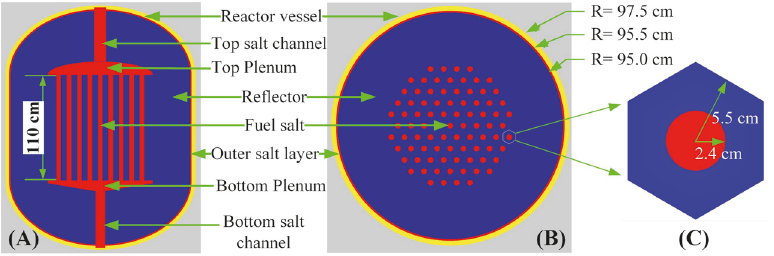
Figure 3: Sketch diagram of the 2MW-MSR. (A) Vertical view; (B) horizontal view; (C) fuel